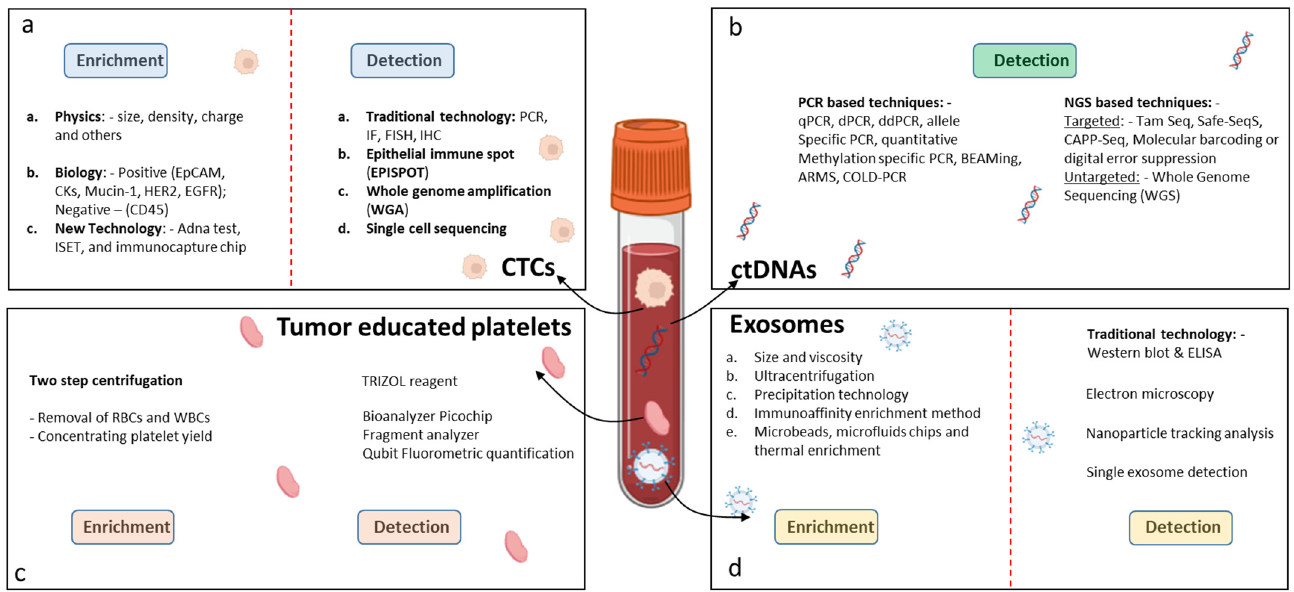
Figure 2. Techniques for detection of LB biomarkers in GICs. ( a ) Detection of CTCs, ( b ) detection of ctDNAs, ( c ) detection of tumor-educated platelets, and ( d ) detection of exosomes.